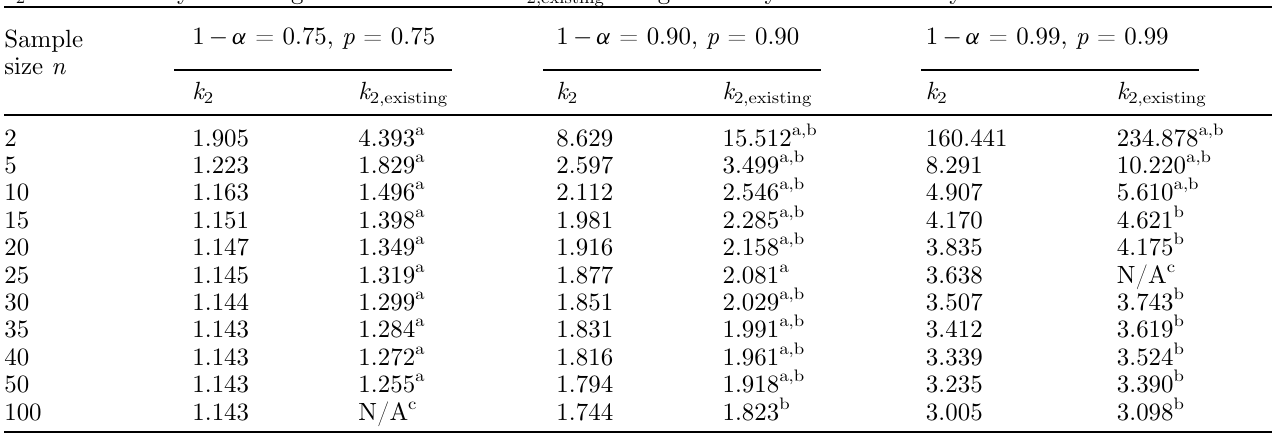
and k 2 2,existing. being currently used in 2,existing